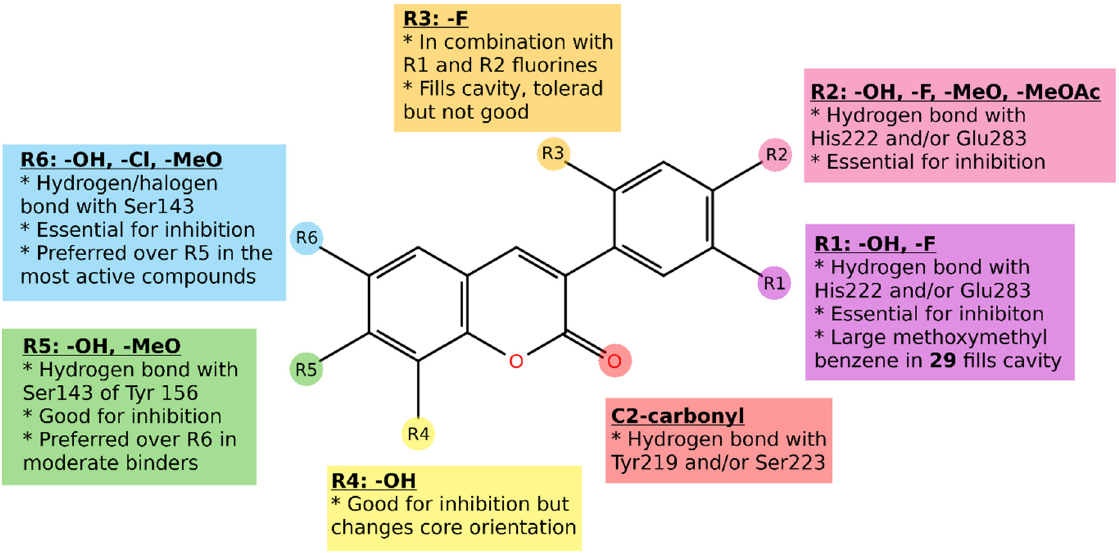
Figure 8. The docking-based structure–activity relationship analysis of the 3-phenylcoumarin derivatives with HSD1.